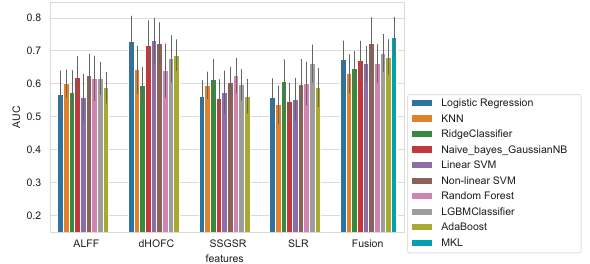
Fig. 4 Classi fi cation AUC of different measures and multi-modal fusion strategies. Compared to other measures, PC-derived dHOFC shows higher AUCs on the algorithms except for the Ridge Classi fi er. As for multi-modal fusion, MKL outperformed the early fusion strategy and achieved the highest AUC (0.7408), while both dwarfed the unimodal